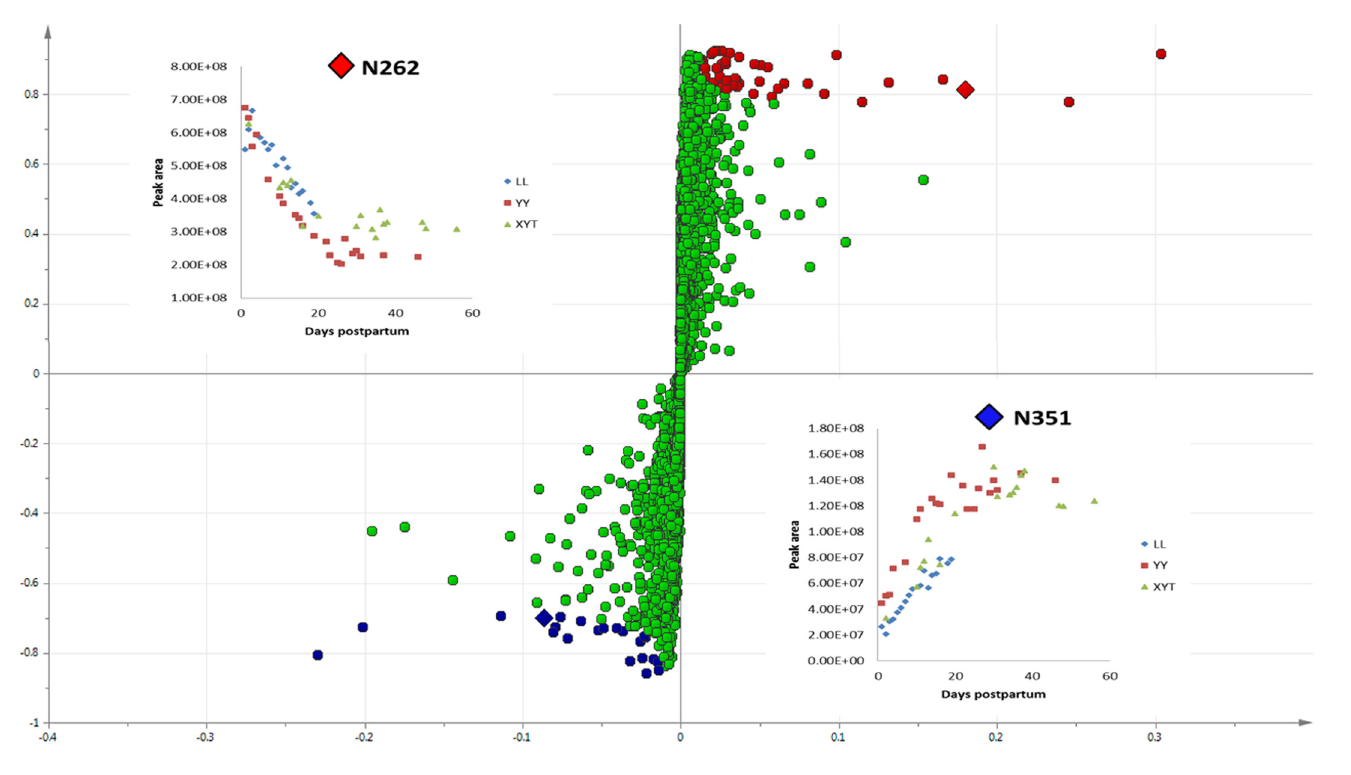
Fig 2. Changes in milk metabolome delineating discrete phases in early lactation. S-plot of orthogonal partial least squares discriminant analysis (OPLS-DA) of 55 giant panda milk samples collected serially after birth from three giant pandas. In an S-plot, the x variable is the relative magnitude of a variable, and the y variable is the variable confidence/reliability. So, data points falling in the upper right or lower left corners of the plot represent those features that are least likely to be the result of spurious correlations. Peaks with low magnitude/intensity falling in the centre of the plot near 0 are close to the noise level and exhibit high risks for spurious correlations. The 50 most abundant compounds in the early phase (before day 7; Phase 1) and the 20 most abundant in later milk (after day 7; Phases 2 and 3, cumulative) are highlighted in red and blue, respectively. The inset graphs describe the time-dependent changes in abundance of two oligosaccharide isomers N262 and N351 (identified as diamonds in the S-plot), subsequently identified as 3 ’ -sialyllactose and 6 ’ -sialyllactose,